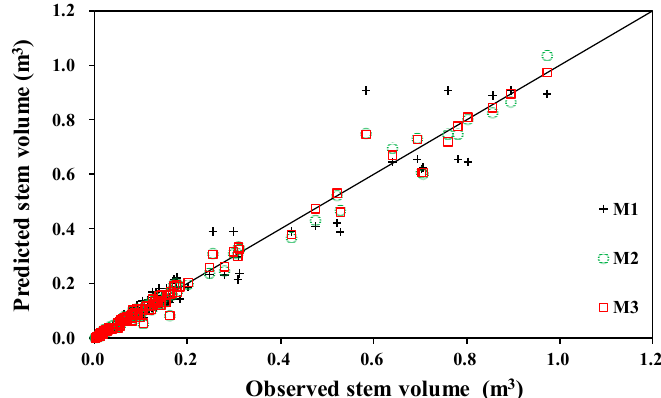
Figure 5. The observed and predicted values of the stem volume. The three stem volume models used were M1, M2, and M3 based on D only; D and H ; and D , H , CL , and CW , respectively.